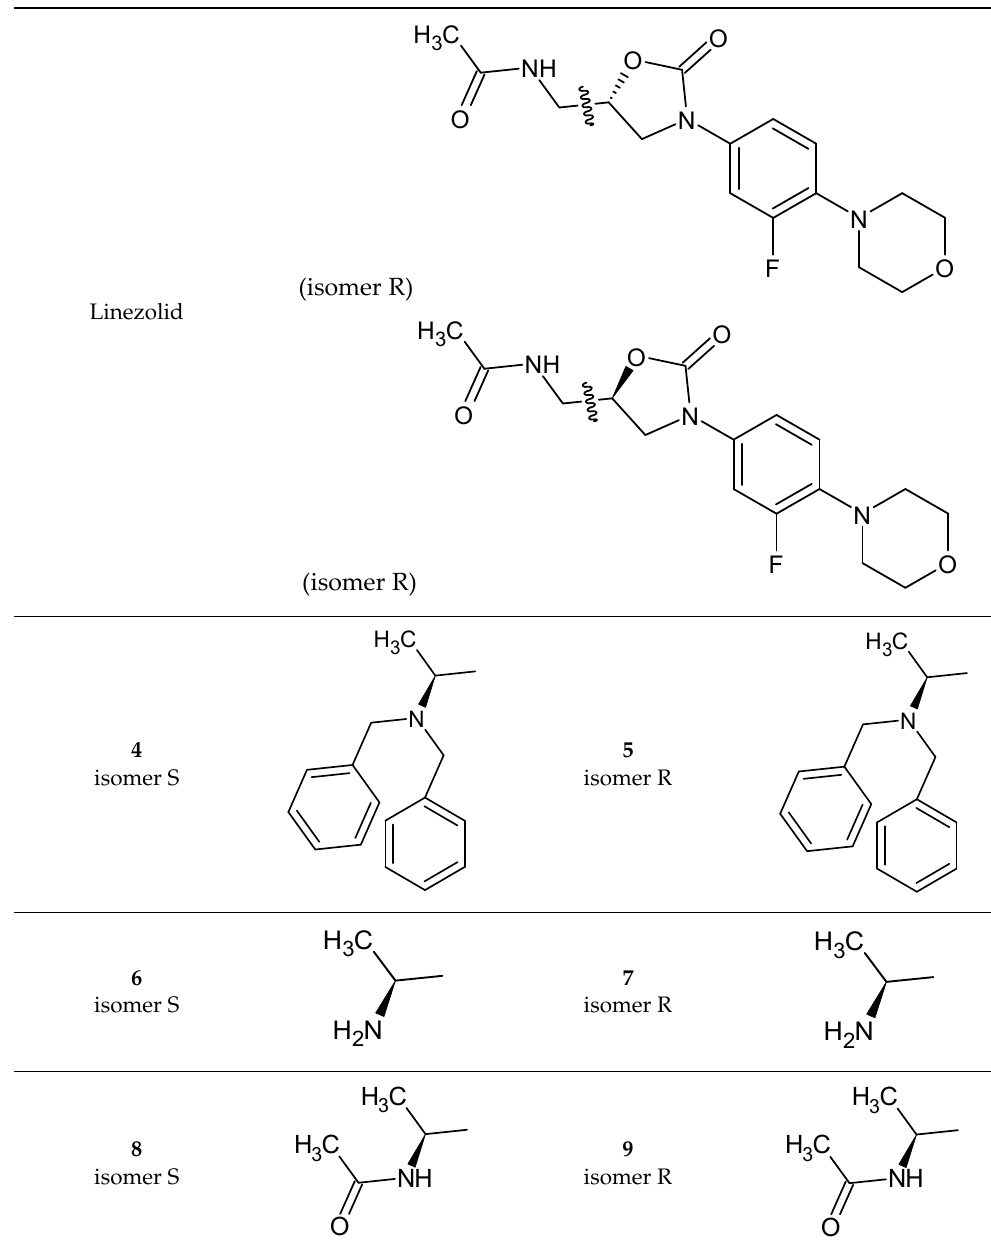
Table 1. The structure of six new linezolid analogs.